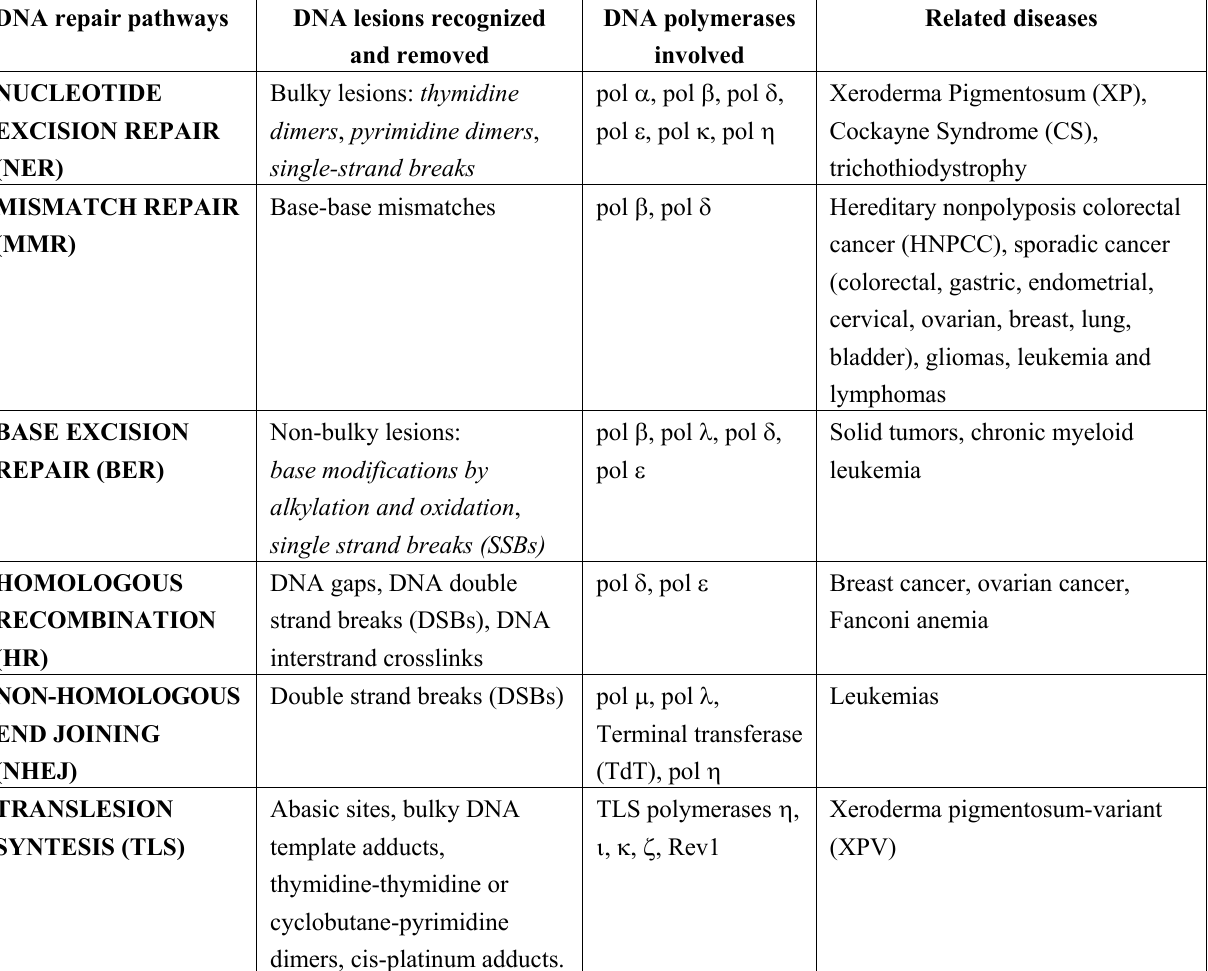
Table 1. Specialized DNA pols and their involvement in specific DNA repair pathways. DNA repair pathways DNA lesions recognized DNA and removed